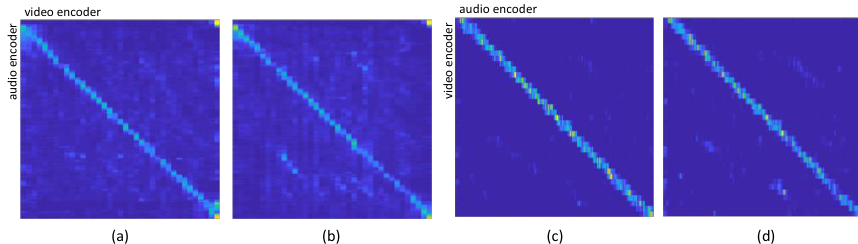
Figure 6. DCM attention weight maps between audio and video encoders using audio or video features as queries in the TM-DCM for clean and noisy reverberant data. The used clean utterance was “PSlBlZ3hqKc/00011.mp4” in the test set of the LRS3-TED dataset, whose character label was “that is the real world and unless we find a way to globalize democracy or”. The input SNR for noisy reverberant data was 0 dB. The weights were computed by averaging over all the cross-modality attention heads. The weight maps for ( a ) clean audio query and video key/value; ( b ) noisy reverberant audio query and video key/value; ( c ) video query and clean audio key/value; and ( d ) video query and noisy reverberant audio key/value.